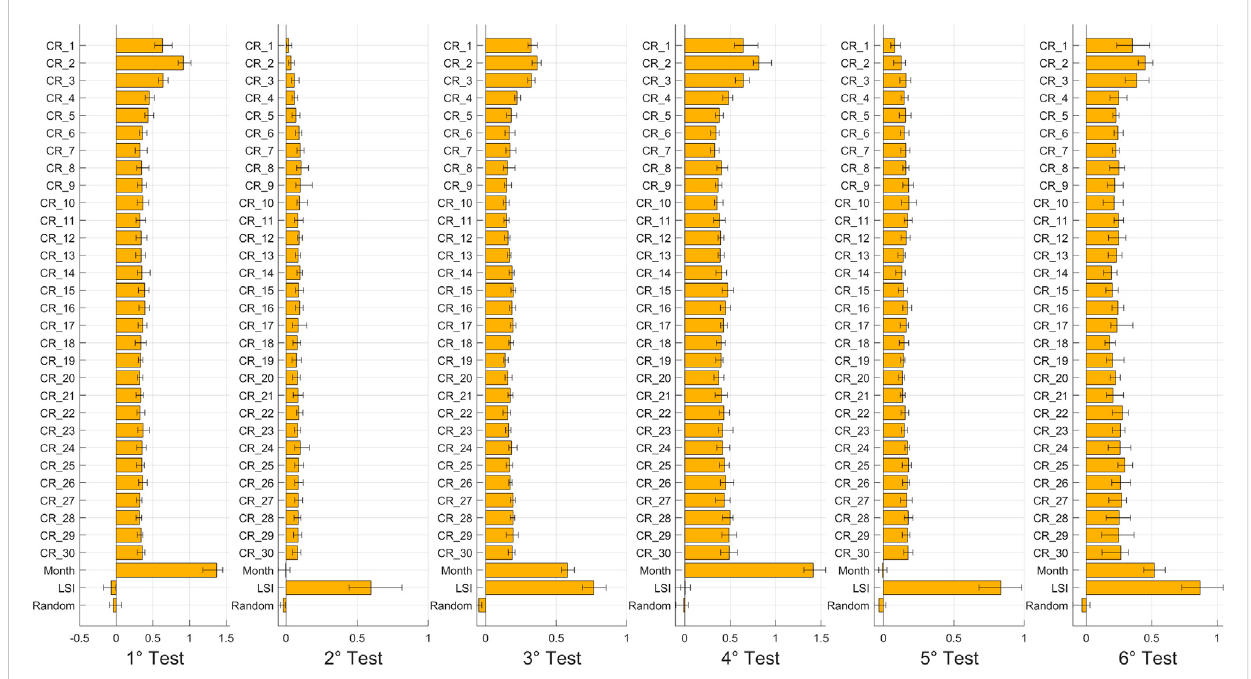
FIGURE 4 Histograms of OOB Permuted Predictions Importance Estimates for each test for the fi rst con fi guration.